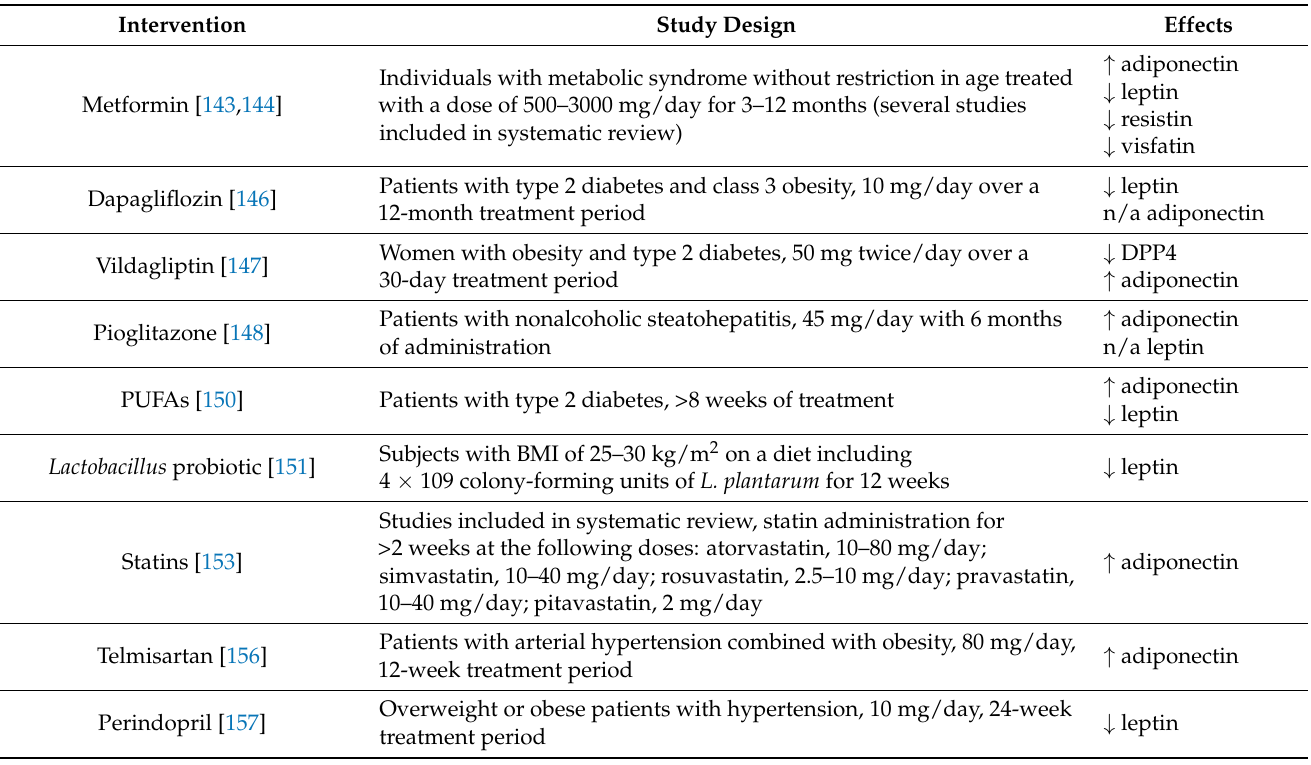
Table 2. Preparations modulating circulating adipokine